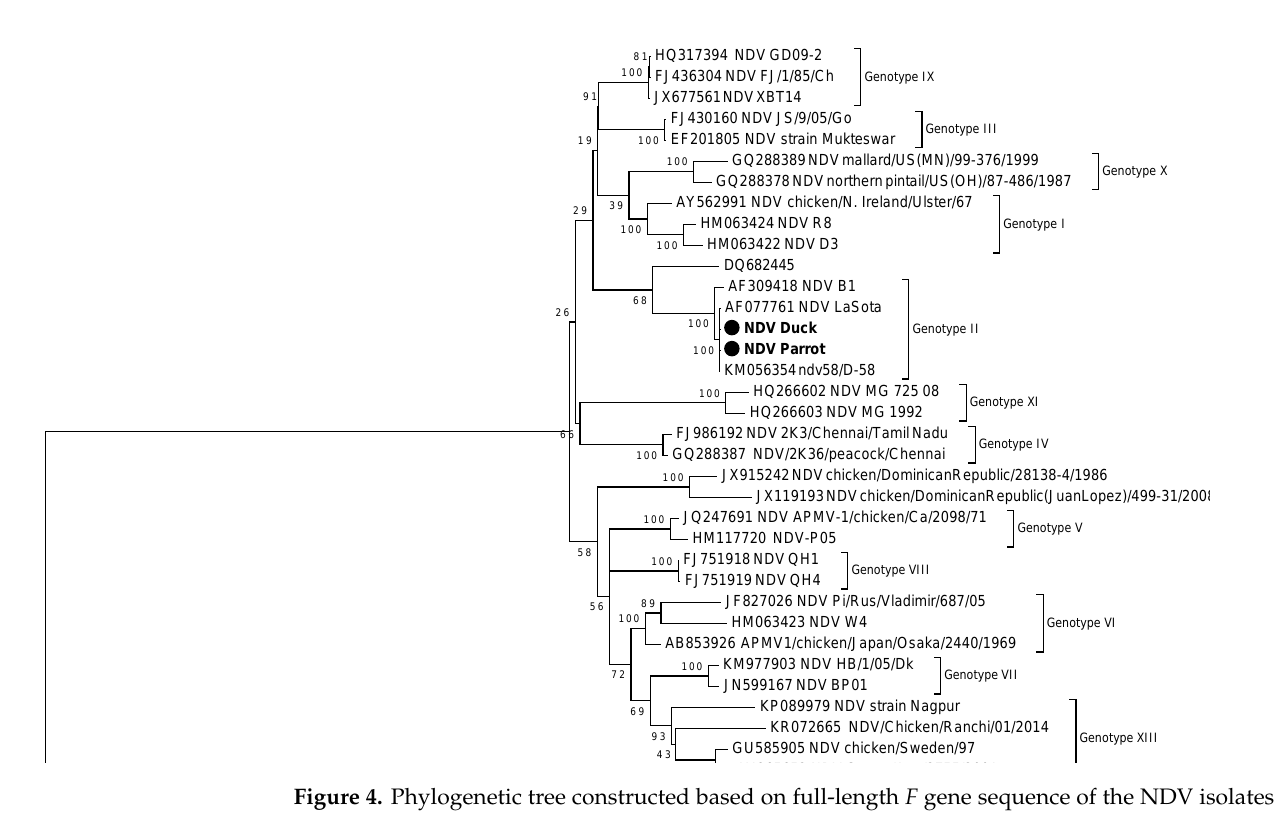
Figure 4. Phylogenetic tree constructed based on full-length F gene sequence of the NDV isolates. The tree was constructed using the neighbor-joining algorithm of MEGA X (1000 bootstrap repetition).